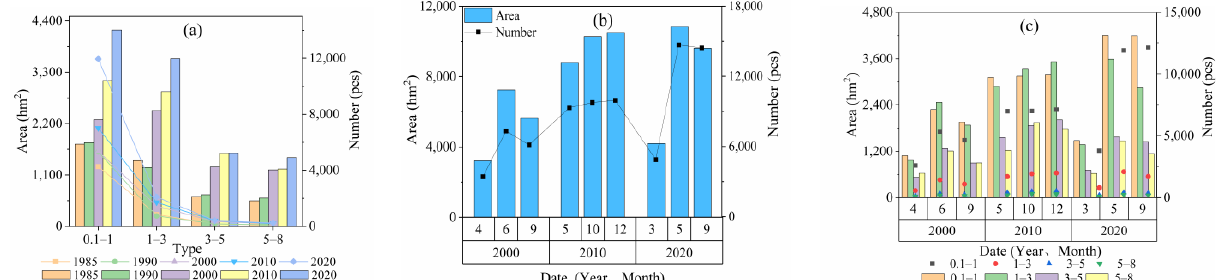
Figure 6. Interannual variations of natural small and micro wetlands in Wuxi from 1985 to 2020 ( a ), and overall ( b ) and within-group seasonal variations ( c ) from 2000 to 2020.